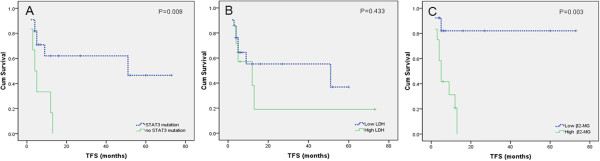
TFS according to the STAT3 mutation status, serum LDH levels and serum β2-MG levels determined at diagnosis. Low LDH group: <250 U/L, and high LDH group: >250 U/L. Low β2-MG group: <3.0 mg/L, and high β2-MG group: >3.0 mg/L. Analysis identified that the shorter TFS in the STAT3 mutation group (A) and high β2-MG group (C), but TFS was not related to LDH levels (B).